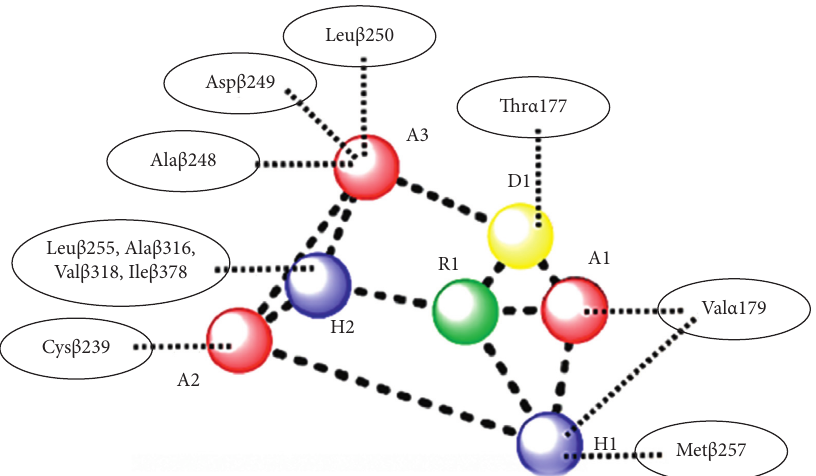
Figure 2: The seven essential pharmacophoric features of CBSIs (based on Ref. [32, 33]).